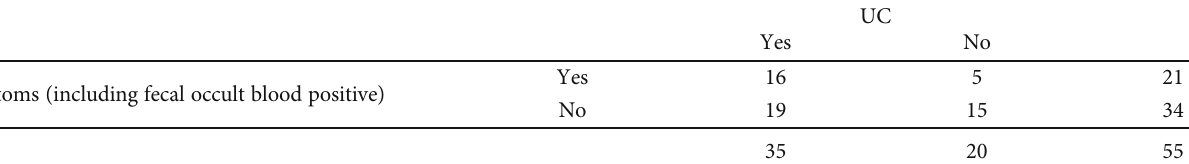
Table 4: Relationship between the reason for colonoscopy and UC ( n = 55